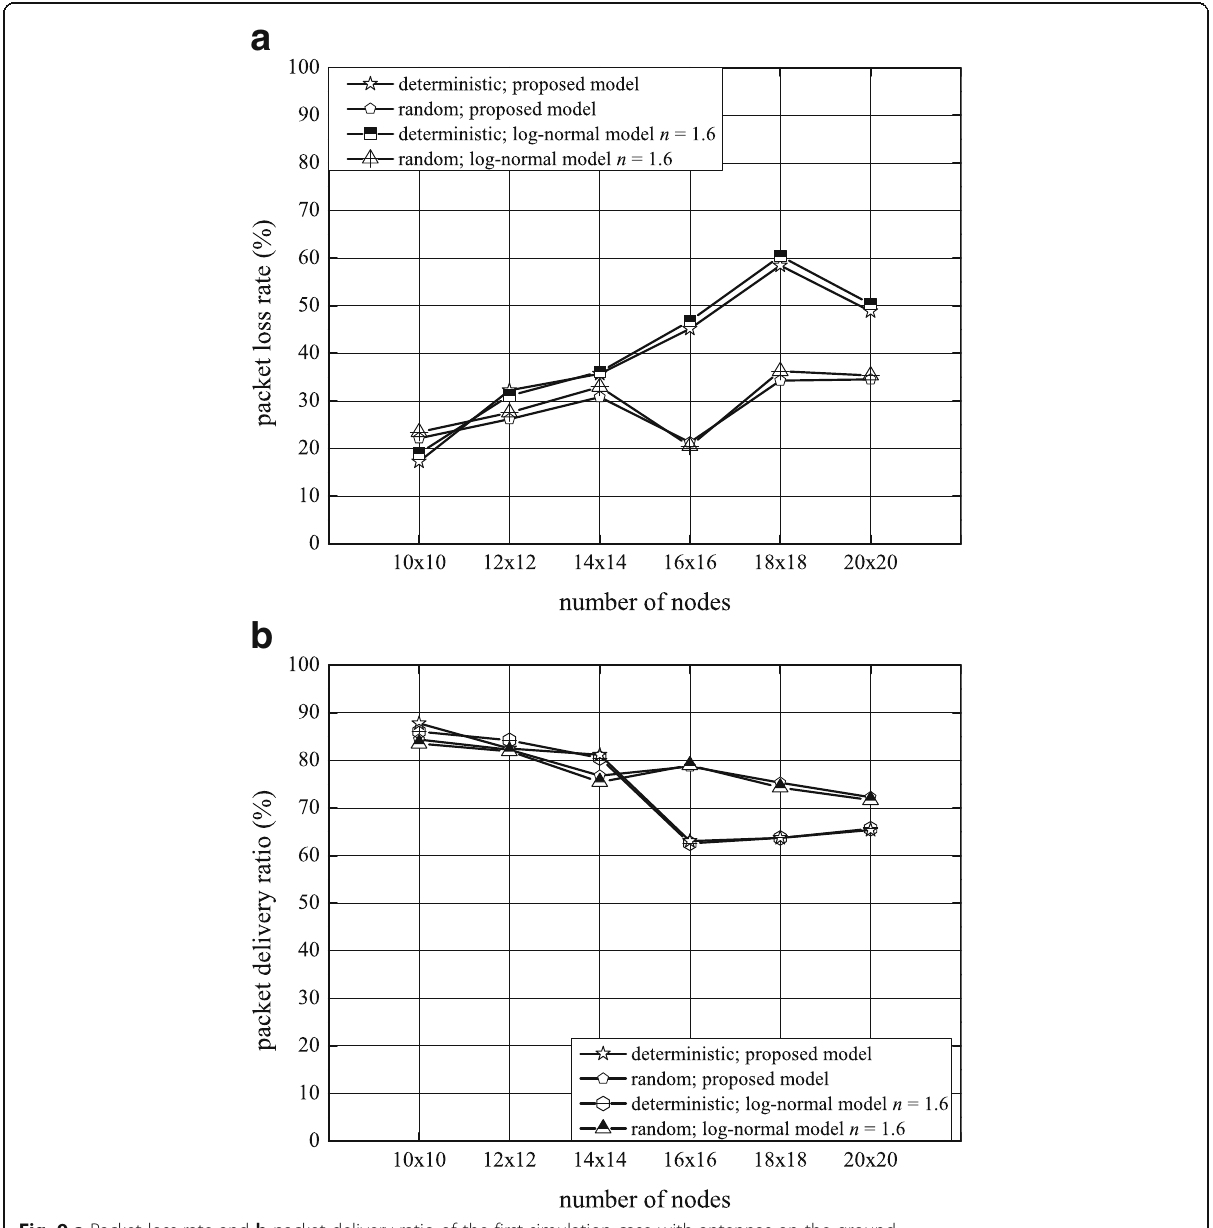
Fig. 9 a Packet loss rate and b packet delivery ratio of the first simulation case with antennas on the